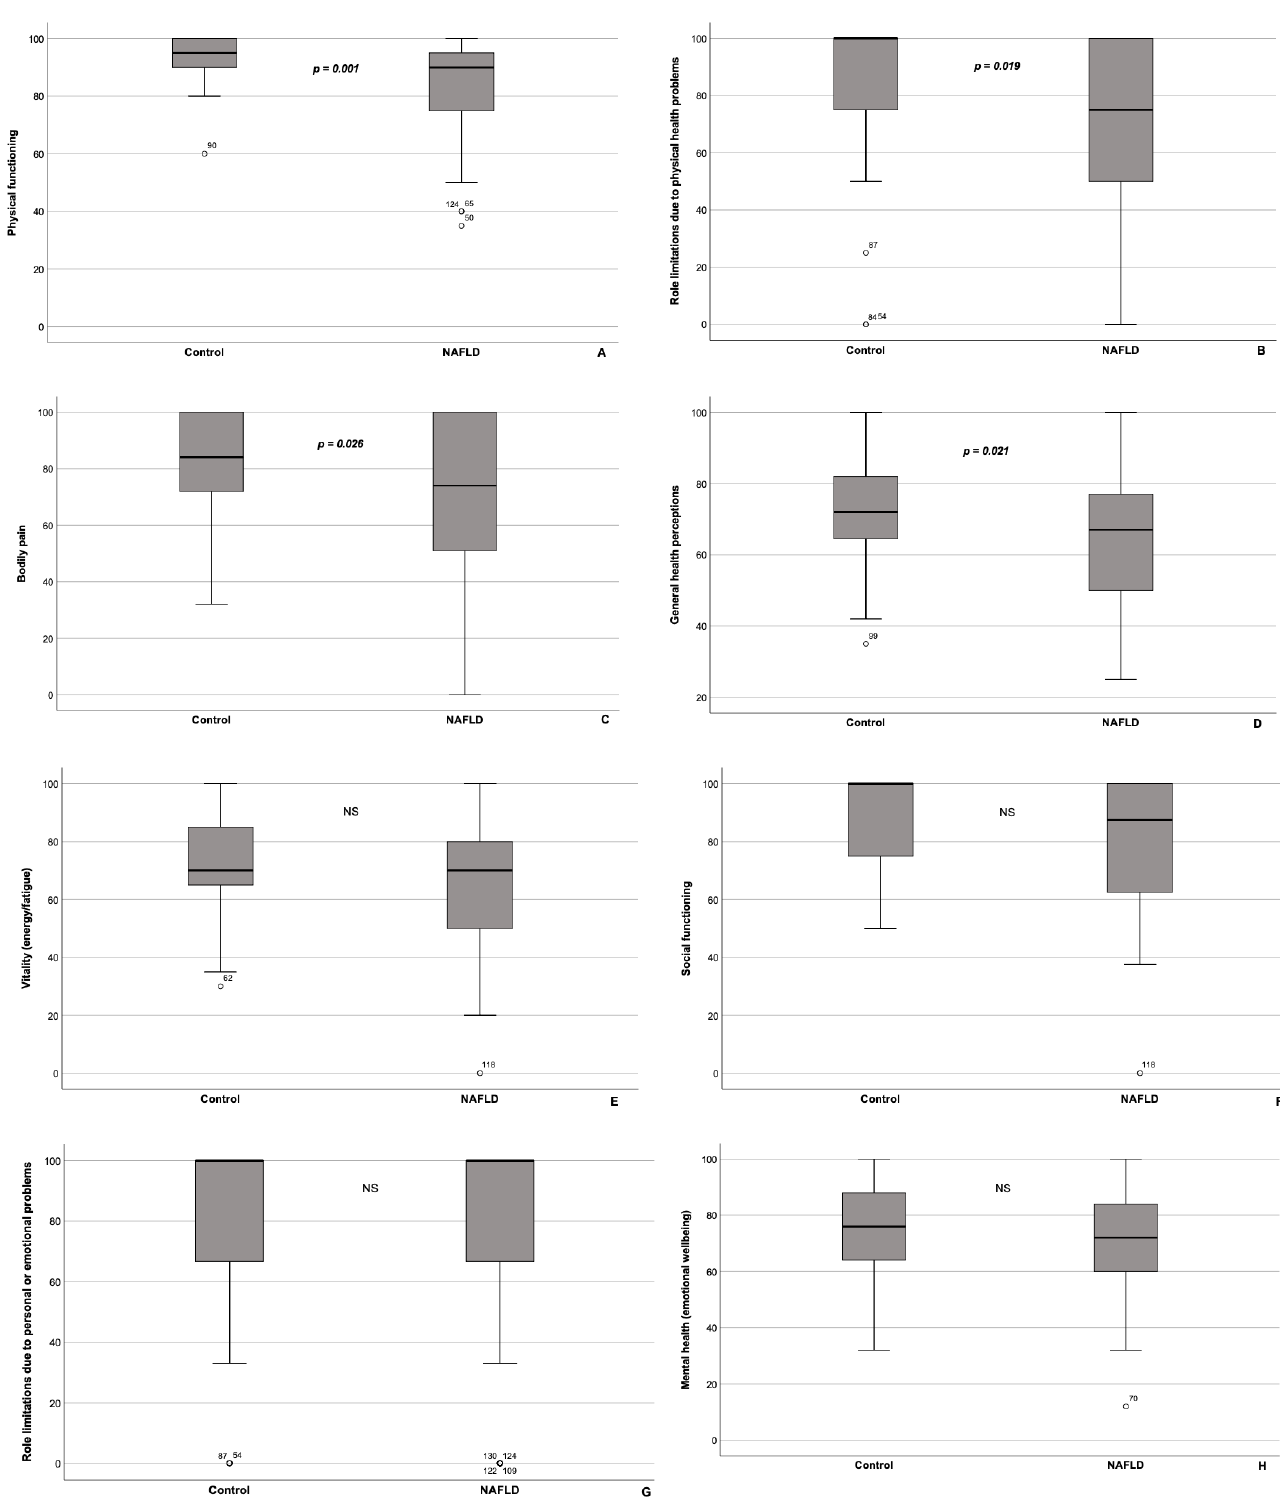
Figure 1. Box Plot of the SF-36 questionnaire subscale values for patients with NAFLD ( n = 95) and controls ( n = 37). Physical functioning ( A ), role limitations due to physical health problems ( B ), bodily pain ( C ), and general health perceptions ( D ) comprise the physical component summary. Vitality ( E ), social functioning ( F ), role limitations due to personal or emotional problems ( G ), and mental health ( H ) comprise the mental component summary. Patients with NAFLD had significantly lower scores on all SF-36 categories, comprising the physical component summary score (i.e., physical functioning ( A ), role limitations due to physical health problems ( B ), bodily pain ( C ), and general health perceptions ( D )). On the contrary, scores on the subscales, included in the mental component summary (i.e., vitality ( E ), social functioning ( F ), role limitations due to personal or emotional prob- lems ( G ), and mental health ( H )), tended to be higher in patients with NAFLD, though the differ- ences did not reach statistically significant level. The line through the middle of each box represents the median. The length of the box thus represents the interquartile range. The error bars show the minimum and maximum values of each subscale. Outliers are depicted as circles. All comparisons are performed using Mann-Whitney U test. NS — non-significant. A comparison of FAS scores also revealed that NAFLD patients were more likely to have clinically significant fatigue than control subjects ( 46.7% vs. 28.9%, respectively, χ 2 = 4.008, p = 0.045). According to HADS scores, patients with NAFLD had significantly higher HADS-D scores, compared with the controls (Figure 2A). At the same time, the prevalence of anxi- ety did not differ significantly between NAFLD patients and control subjects (Figure 2B). In addition, we revealed a positive correlation between the HADS-D scores and the FIB-4 index values ( = 0.206, p = 0.048). However, the comparison of HADS-D scores between the subgroups of NAFLD patients with significant fibrosis ( F ≥ 3 on METAVIR scale; FIB- 4 1.3, n = 18) and without it (FIB-4 < 1.3, n = 74) yielded no statistically significant differ- ences. Moreover, there were significant negative correlations between FIB-4 values and PF, as well as BP subscales’ scores (parts of PCS) in the NAFLD group ( = −0 .343, p < 0.001 and = − 0.229, p = 0.027, respectively) . In the control group, we discovered 6 subjects with FIB-4 > 1.3.